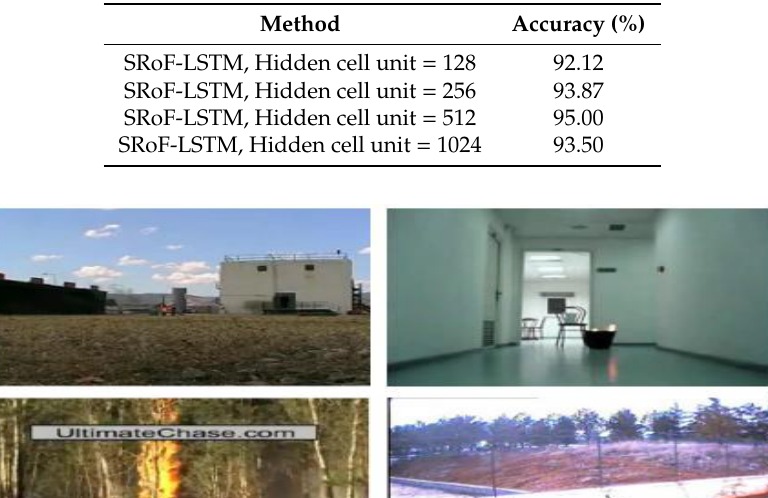
Table 4. Performance of test video clips for LSTM hidden cell unit.